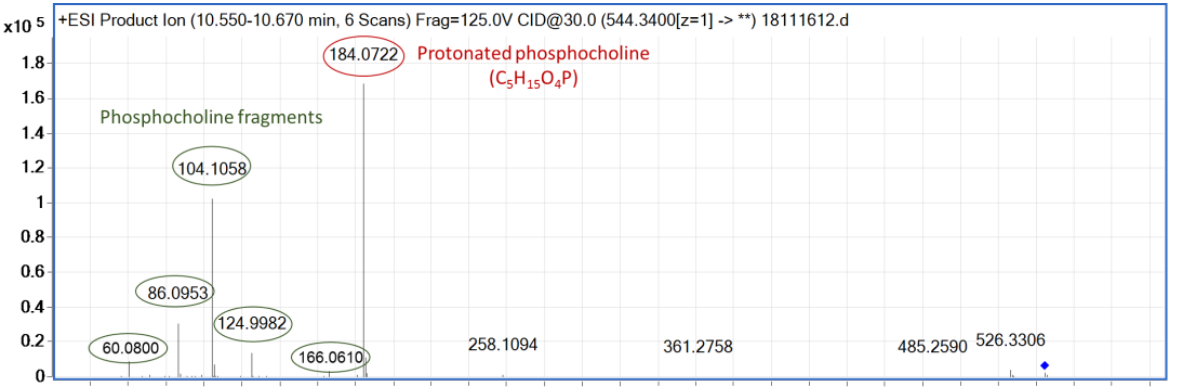
Figure 5. Experimental fragmentation pattern of the significant feature with m / z = 544.3400 and RT = 10.54 min, which has a phosphocholine in its structure.